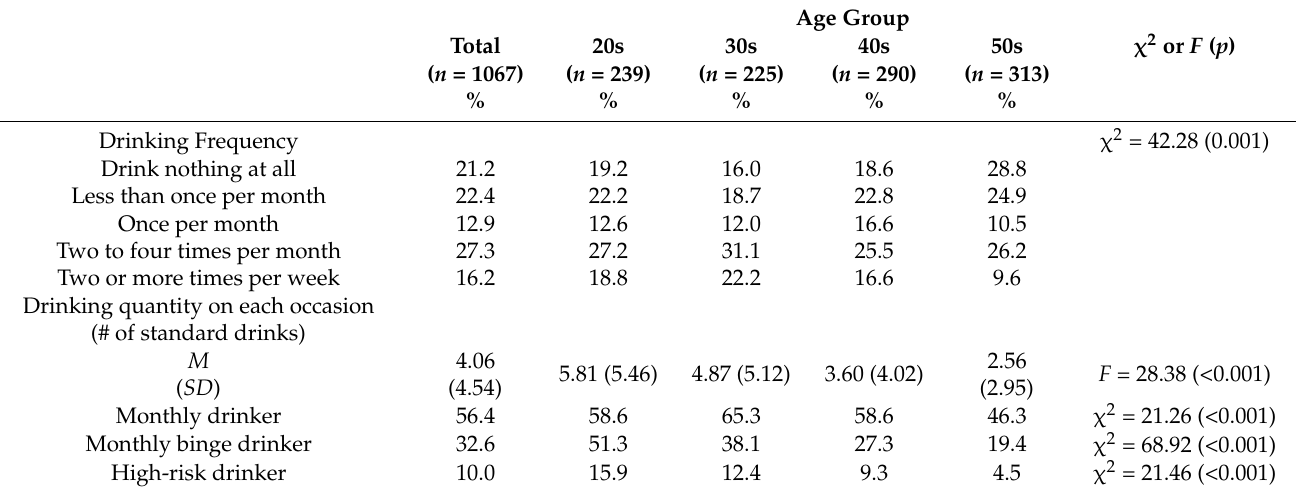
Table 1. Drinking behaviors across age groups ( n =